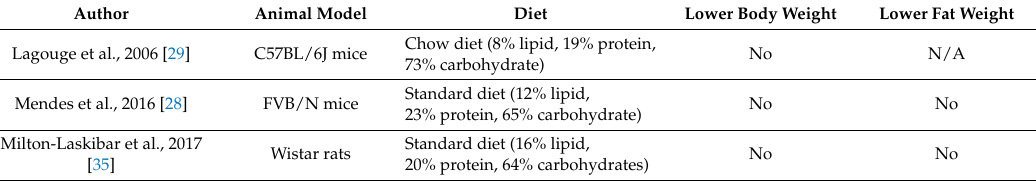
Table 2. Preclinical studies performed administering resveratrol under standard